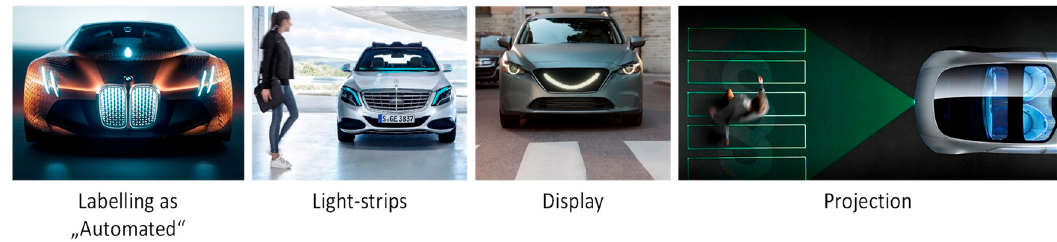
Figure 5. Categorization of different visual eHMI types clustered in the groups labelled